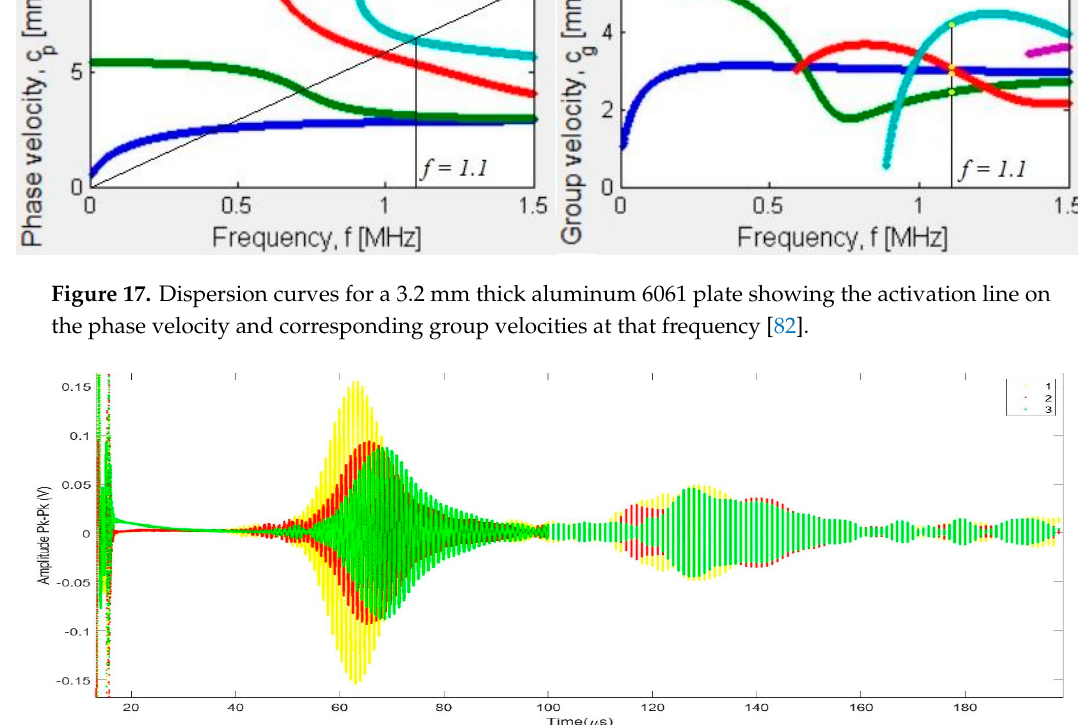
Figure 19. Frequency spectrum for one of the guided modes. The presence of harmonics is also indicated [7]. Signal-to-noise ratio (SNR)was calculated by taking the ratio of the root-mean-square (rms) value of the amplitude (peak-to-peak) within the mode window to the rms value of the noise window in decibel units given by this formula.